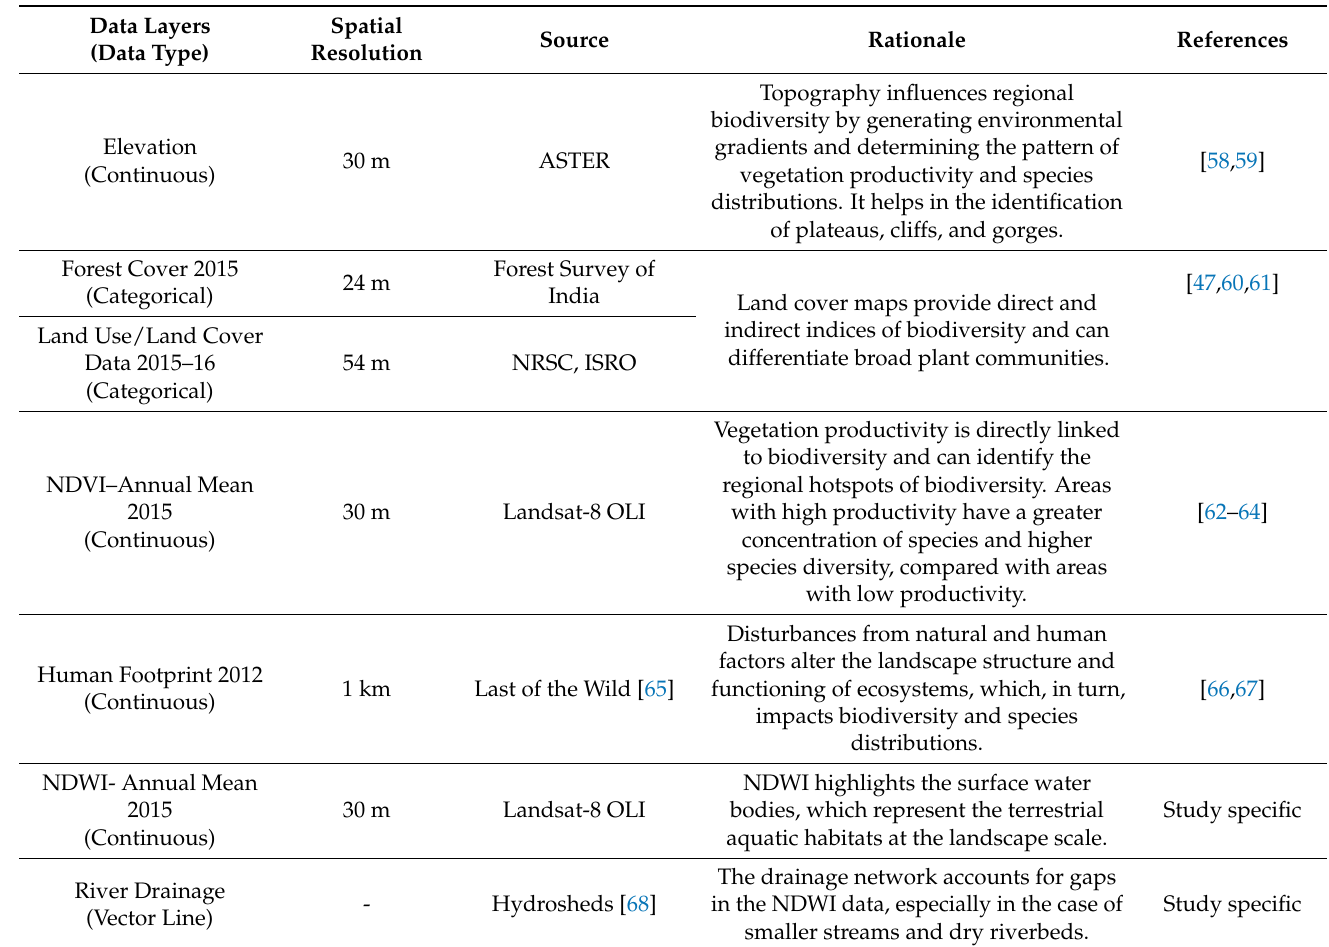
Table 1. Earth observation data products used in the computation of variables for biodiversity